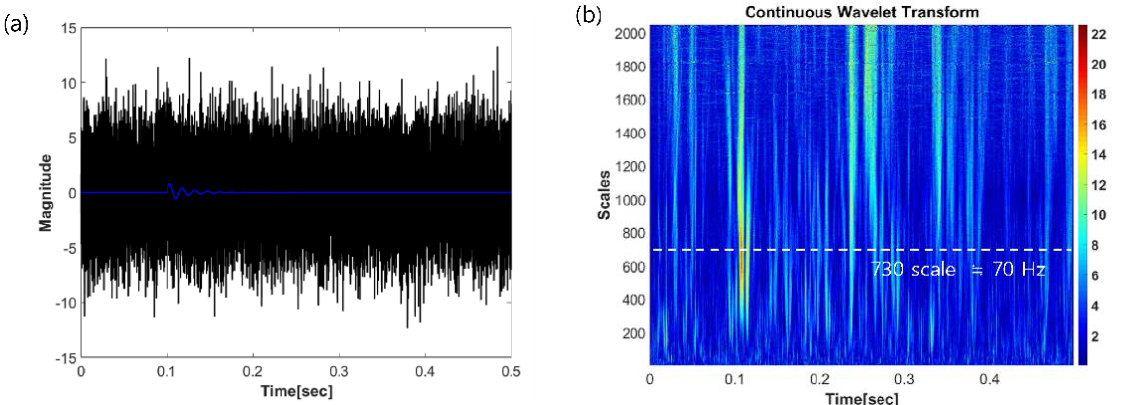
Figure 4. An impact signal with white noise (SNR: − 30 dB) ( a ) and its continuous wavelet transform ( b ); the blue line in ( a ) is the same signal as in Figure 3a.